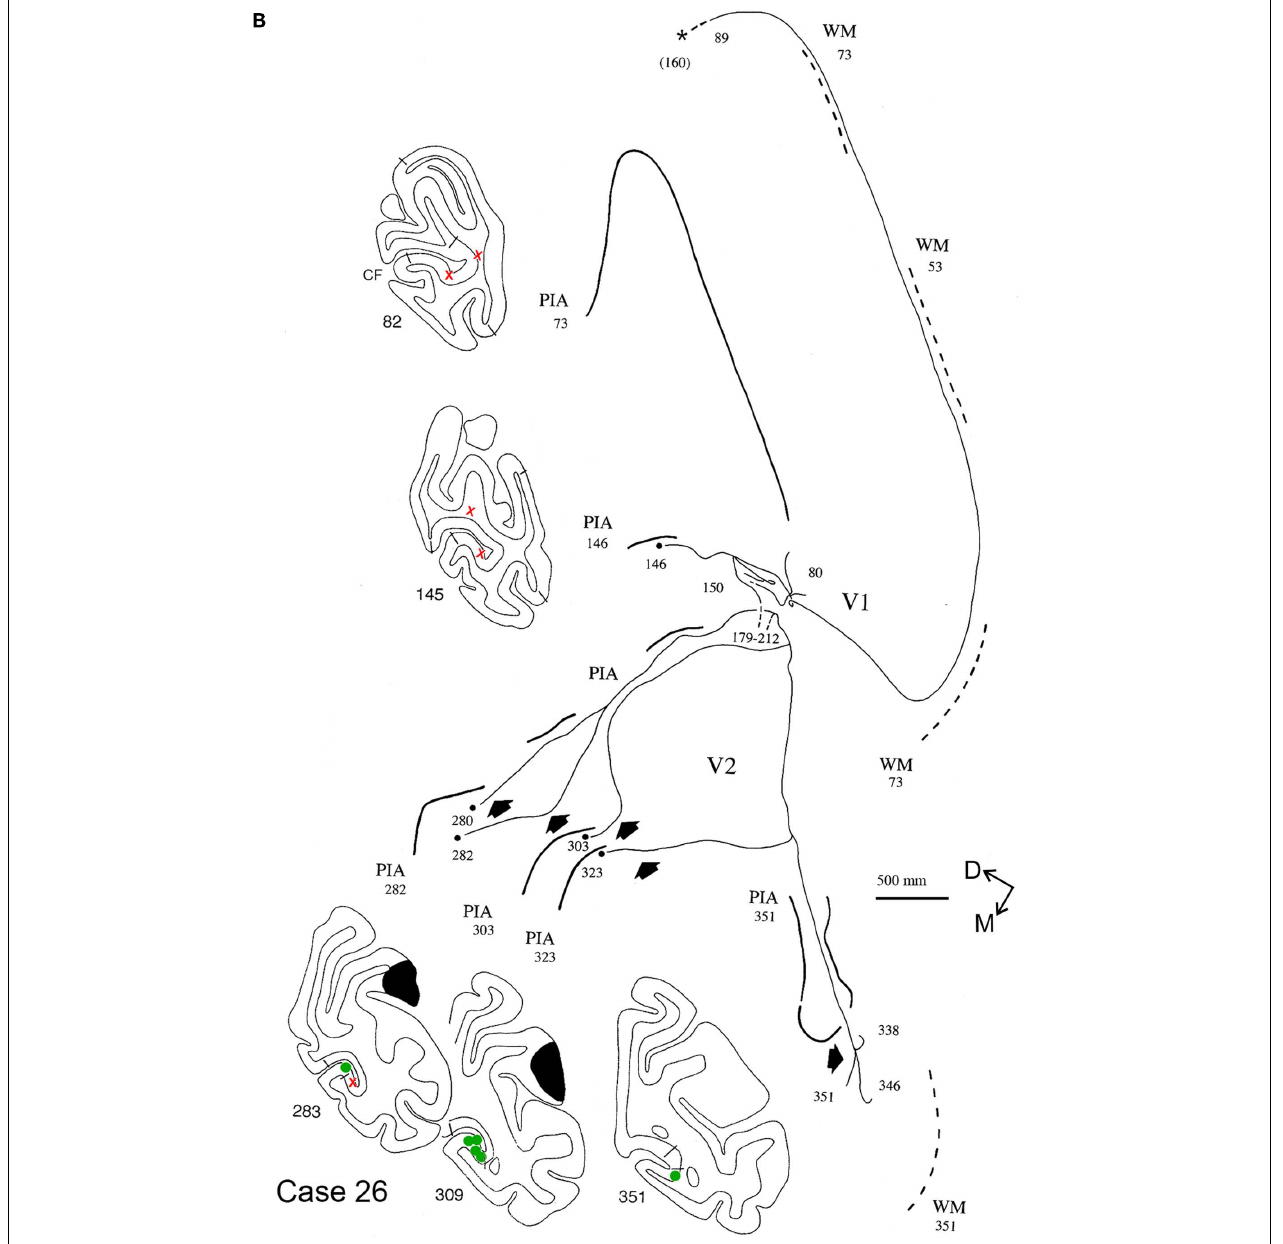
ofV2. InV2, four collaterals (short, solid arrows), spaced about 1.0mm apart (AP), extend variable distances from the ventralV1/V2 border.The total extent of this axon is 13.0mm AP by 3.6mm DV. Dashes at sections 179–212 indicate a gap (in the summary reconstruction, but not in the raw data), where a portion of the axon has not been depicted, for the sake of space. Asterisk denotes the main axon, which was followed toward the injection site until section 160 (almost 4mm rostral). Conventions as in Figures 2 and 4